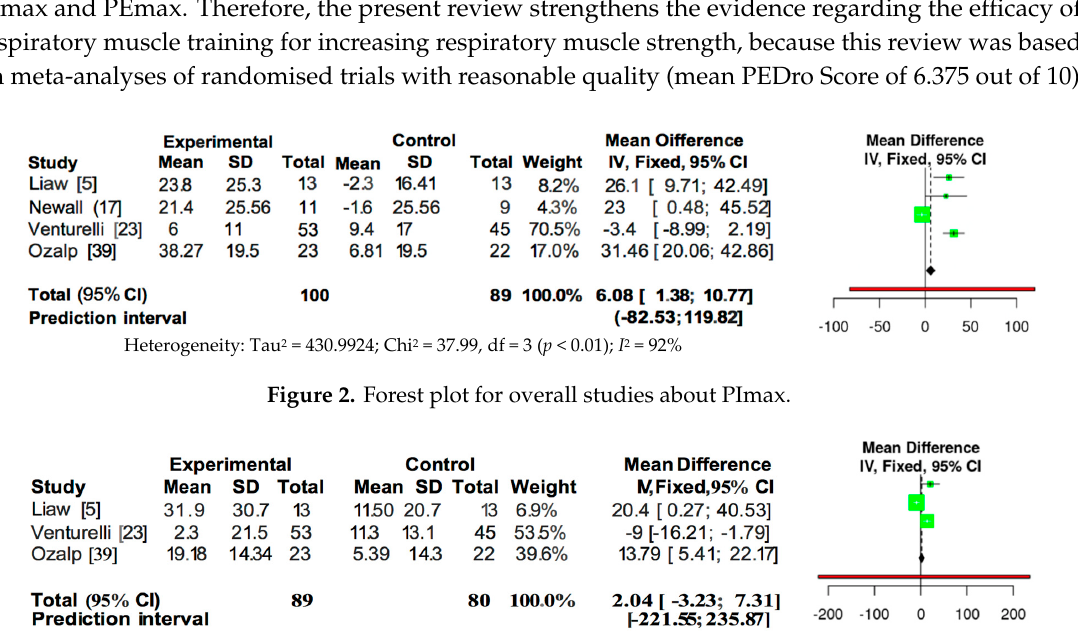
Figure 3. Forest plot for overall studies about PEmax.